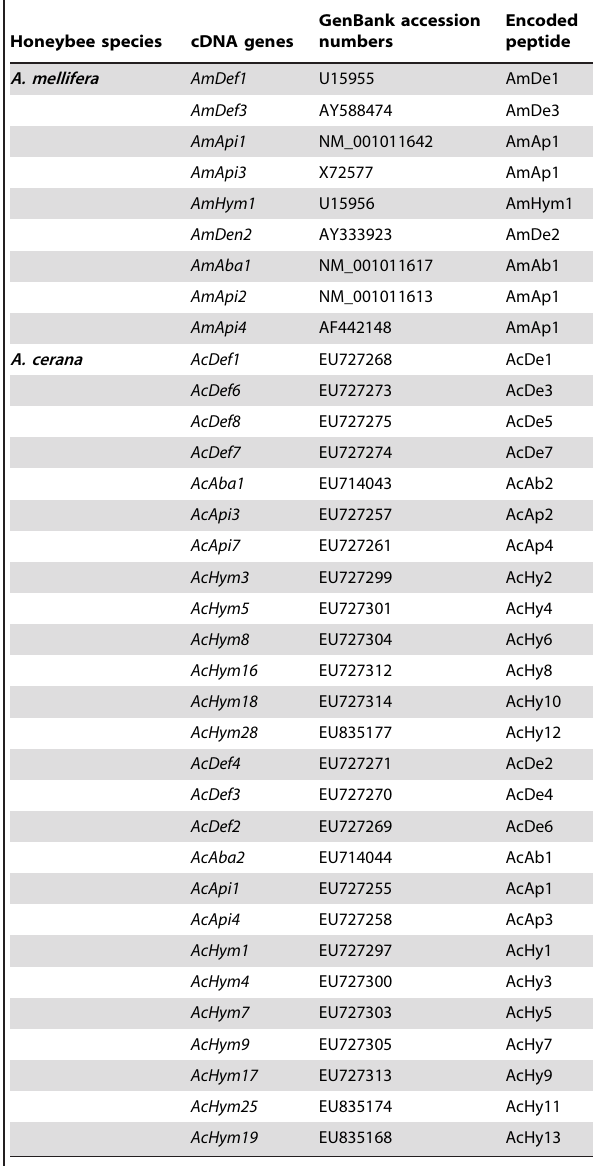
Table 1. Four antimicrobial peptide cDNA gene families of A. cerana and A. mellifera selected to construct the phylogenetic